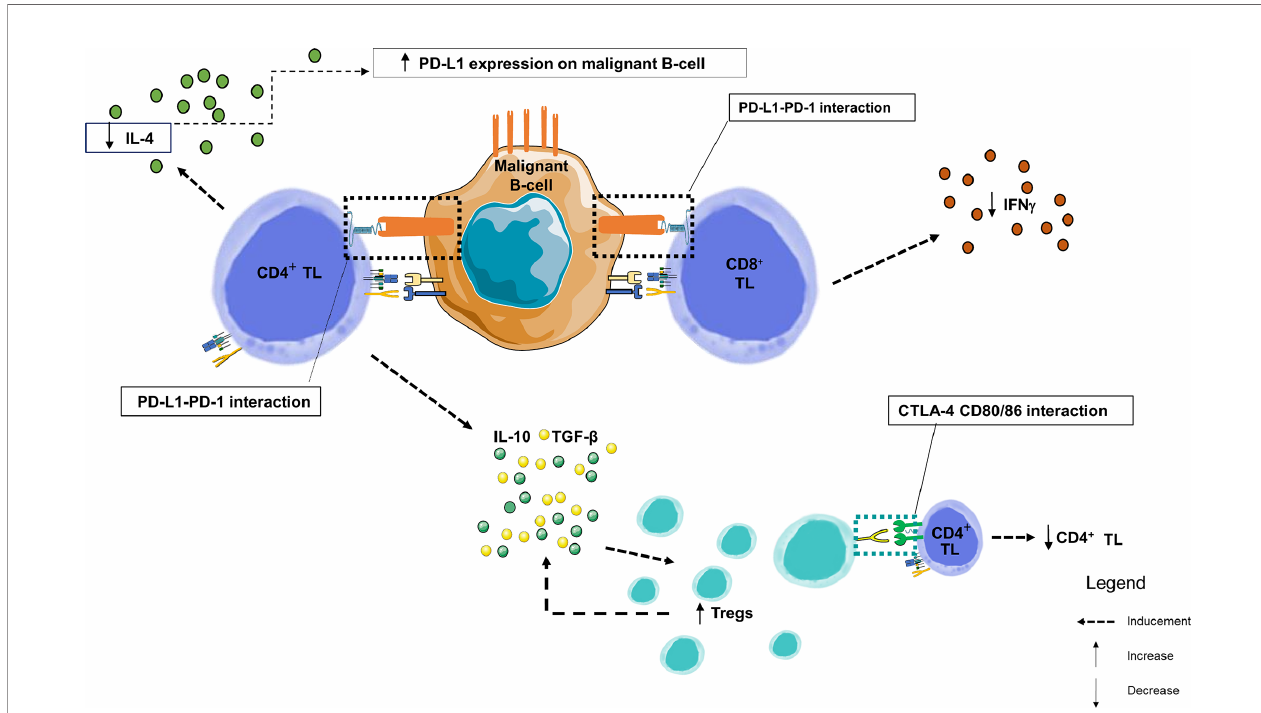
FIGURE 5 | Immune synapse in a CLL node. This fi gure focuses on the germinal centers of lymph nodes. By combining data from several studies in lymph nodes and peripheral blood, we observe that PD-1 and PD-L1 are heterogeneously expressed markers of B lymphocytes from chronic lymphoid leukemia. Similarly, PD-1 is overexpressed in TLs in fi ltrating the CLL microenvironment. Within the malignant lymph node proliferation centers, PD-1+ CD4+ TLs are in close contact and interfere with PD-L1+ CLL leukemic B-cells. The number of CD8+ and CD4+ TLs are higher in CLL patients than in healthy donors, with an increase in effector TL number and a decrease in naive TLs. IFN g production by TLs enhances PD-L1 expression. However, when PD-1 and PD-L1 interact, there is a signi fi cant decrease in IL-4 and IFN g production by CD4+ and CD8+ TLs, respectively, creating a negative feedback loop, and a signi fi cant increase in the proportion of CD4+ CD25+ FOXP3 + CTLA-4+ Tregs in CLL patients. TGF- b and IL-10 are overexpressed by the CD4+ TL and Tregs and play an important role in their inhibitory function (106); IFN g , Interferon Gamma; IL-4, Interleukine 4; IL-10, Interleukine 10; PD-1, Programmed Death 1; PD-L1, Programmed Death Ligand 1; TGF- b , Transforming Growth Factor Beta; TIL, Tumor-in fi ltrating Lymphocyte; TL, T Lymphocyte; Tregs, Regulatory T